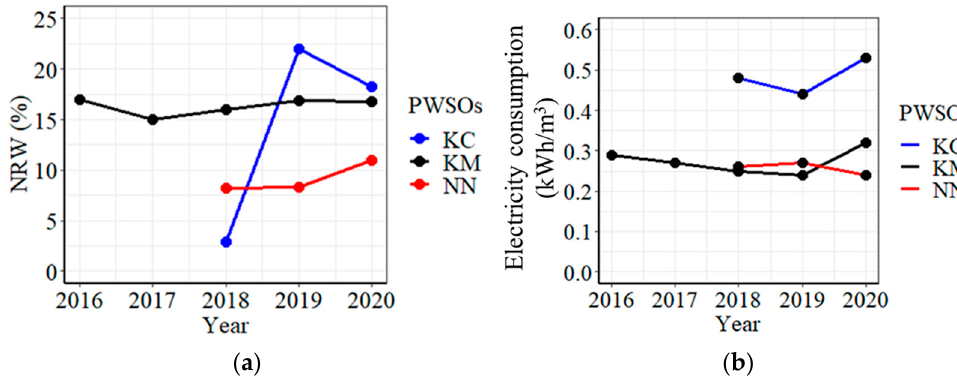
Figure A2. ( a ) NRW of each PWSO and ( b ) electricity consumption.